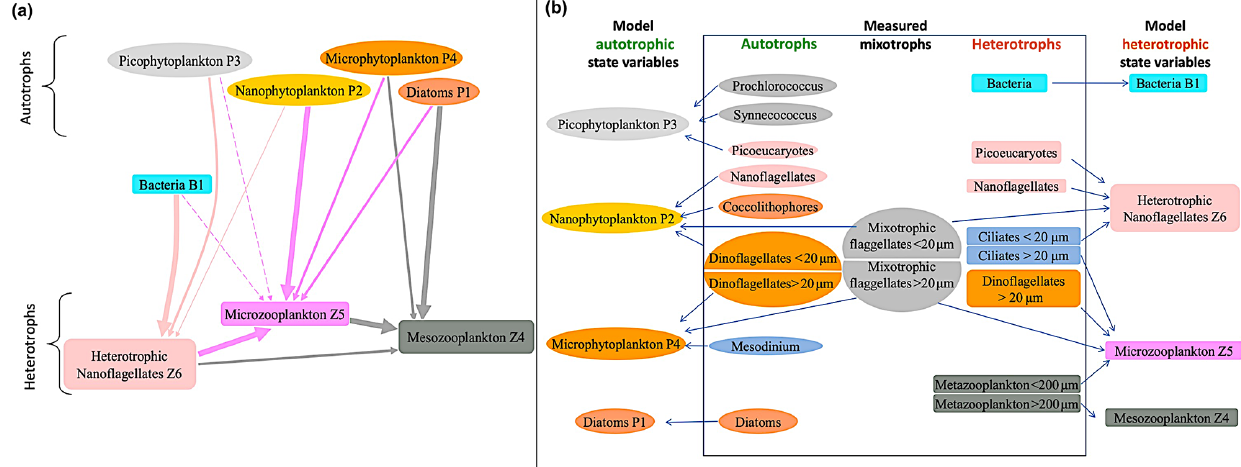
Figure 12. ERSEM model’s food web structure (a) and correspondence between model variables and measured variables at the Cretan Sea observatory (b)